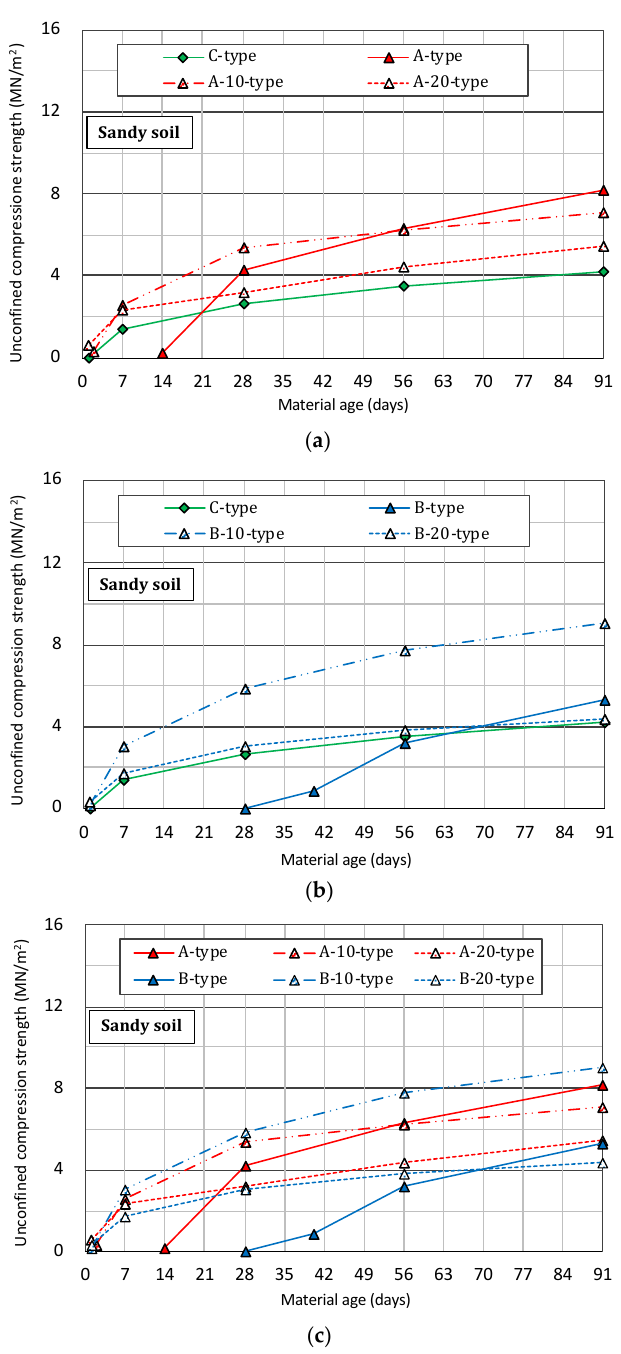
Figure 4. Changes over time in the unconfined compression strength of the specimen prepared by mixing sandy soil and a slurry solution of various solidifying materials with the passage of the material age. ( a ) A-type and C-type. ( b ) B-type and C-type. ( c ) A-type and B-type. In the strength comparison between the B-type and the C-type shown in Figure 4b,